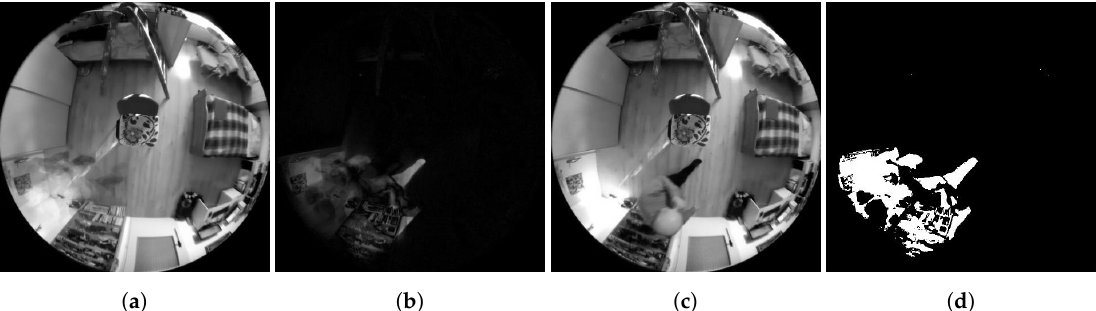
Figure 13. Examples of Method 2.2 functionality. ( a ) Background frame. ( b ) Difference in brightness between the currently checked frame and the background frame. ( c ) Currently checked